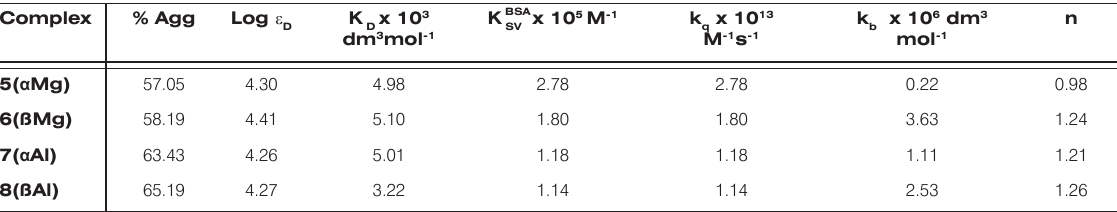
Table 2. Aggregation parameters and BSA binding data for the metallophthalocyanine derivatives